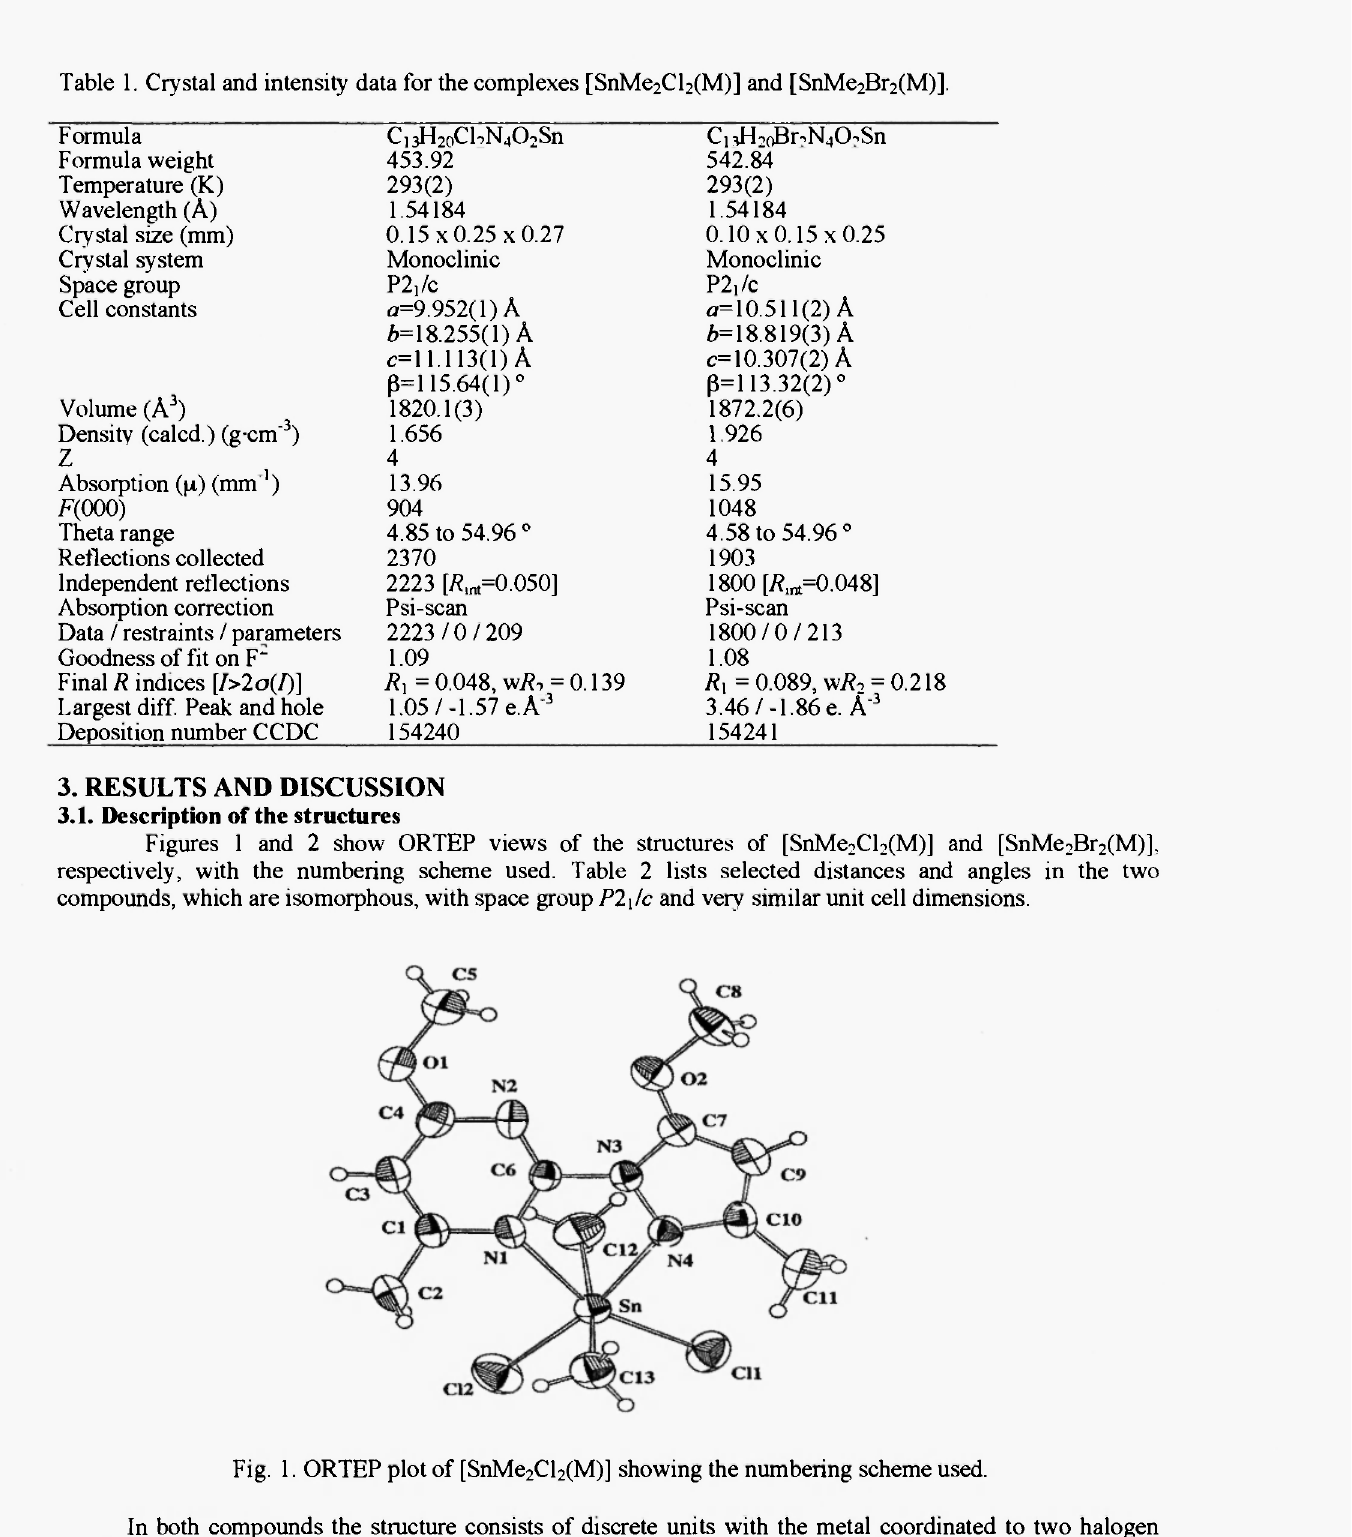
Table 1. Crystal and intensity data for the complexes [SnMe 2 Cl 2 (M)] and [SnMe 2 Br 2